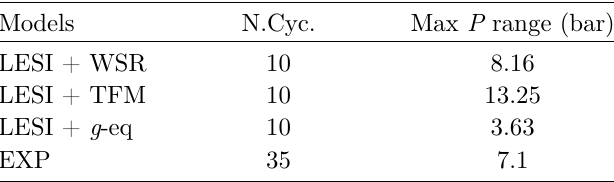
Table 4. CCV metrics for the three simulation setups.